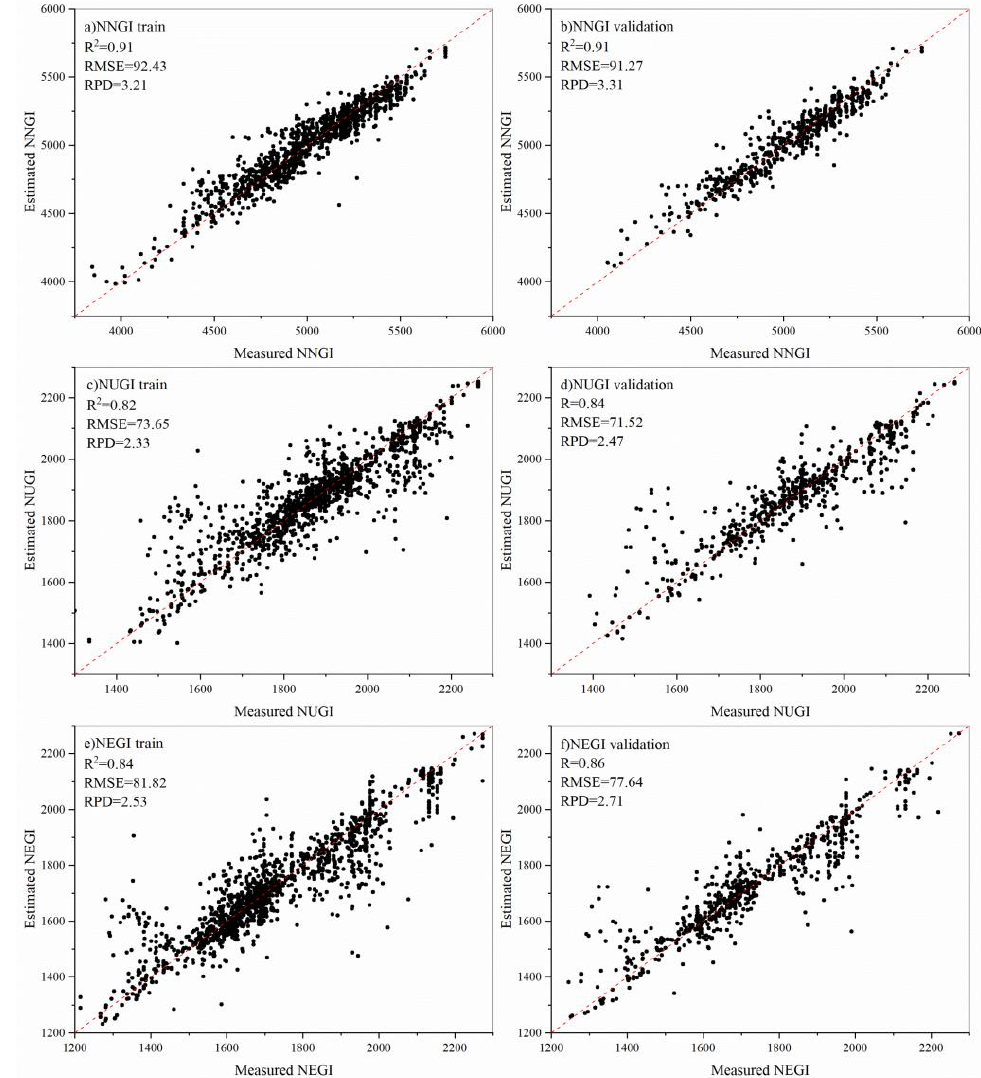
Figure 5. Scatterplots of the measured versus estimated cultivated land quality indices values. Table 3. Classification standard of cultivated land quality.